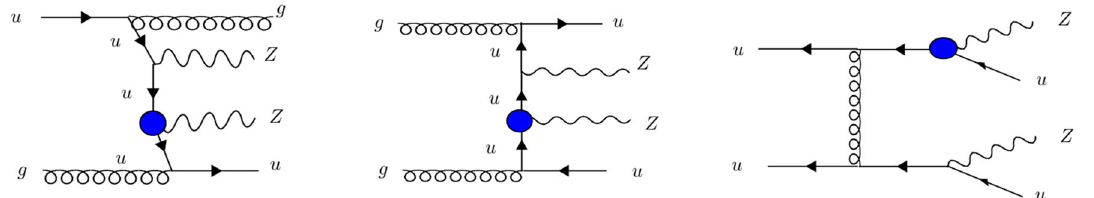
Fig. 10 Some of the Feynman diagrams contributing to the VBS(ZZ) dominant background process in dim = 6 EFT. The blobs represent the dimension-six insertions